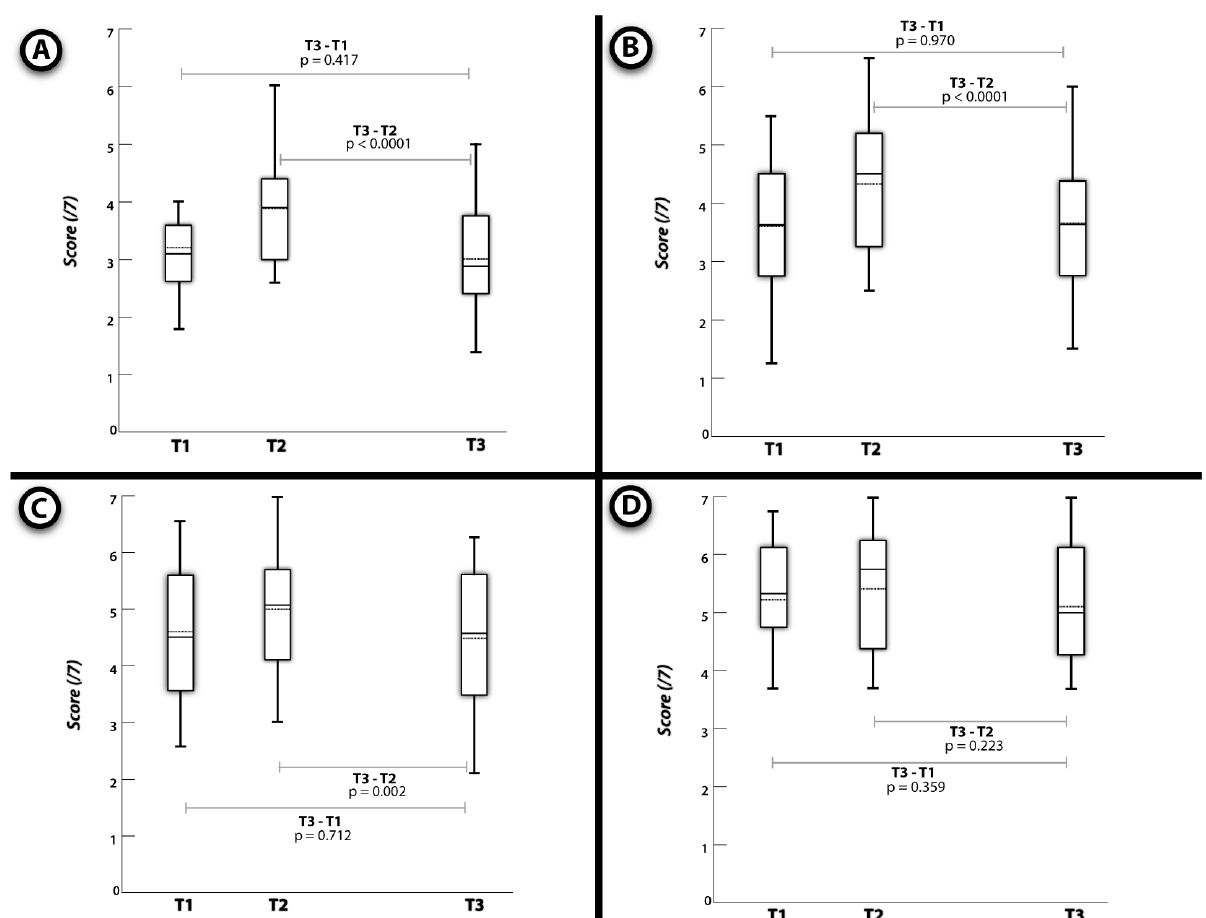
Figure 3. Changes in the four domains (A. dyspnea, B. fatigue, C. emotion and D. mastery) of the CRQ immediately after a pulmonary telerehabilitation intervention and 6 months later (gray lines inside the boxes are means, black lines are